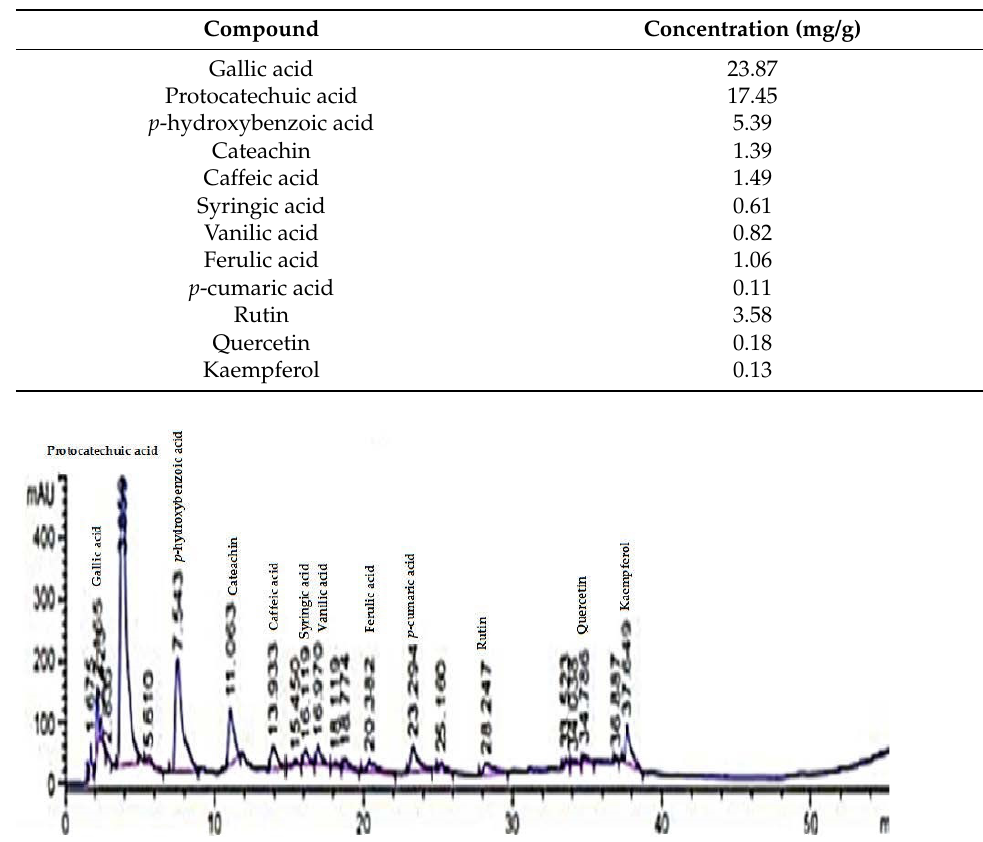
Figure 1. HPLC of different phenolic compounds in grape seed powder.